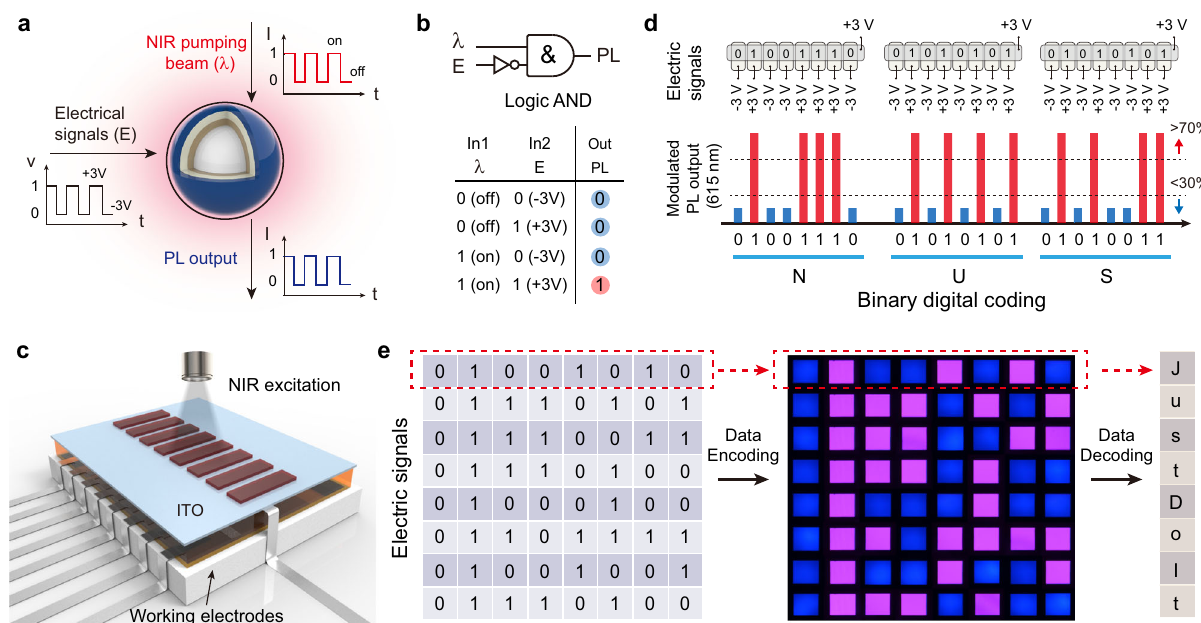
Fig. 4 Demonstration of opto-electrochemical logic AND gate using PV-modi fi ed UCNPs. a , b Basic operating principle of logic AND gate based on the Eu-UCNP/PV platform. The nonlinear output signal is programmed by a NIR laser and an alternating electric fi eld. Under NIR illumination, the photonic readout is controlled by alternating the electric fi eld, which initiates the redox reaction of PV molecules. c Schematic of an eight-pixeled, UCNP/PV logic gate array, in which each pixel is controlled individually by applying voltages of ±3.0 V. d Information processing of electrical inputs carrying the word “ NUS ” into optical signals using upconversion logic gating. The measured emission intensity of the Eu-UCNP/PV thin fi lm at 615 nm below the 30% or above the 70% threshold represents binary codes, “ 0 ” or “ 1 ” , respectively. e Multiplexed data processing through opto-electrochemical modulation. A string of electrical signals carrying encrypted information of “ Just Do It ” is converted into visible patterns for signal